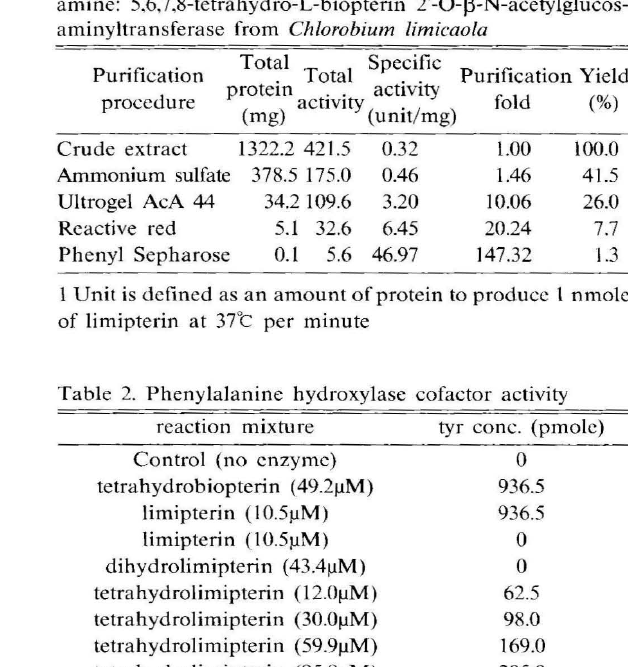
Table I. Summary of purificantion of UDP-N-acetylglucos